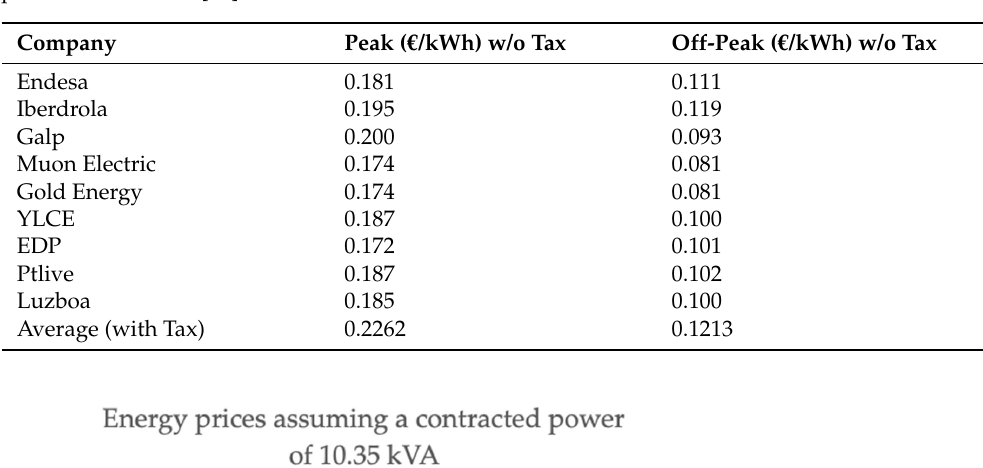
Table 3. Peak and off-peak values of Portugal Continent electricity retailers assuming a contracted power of 10.35 kVA [45].